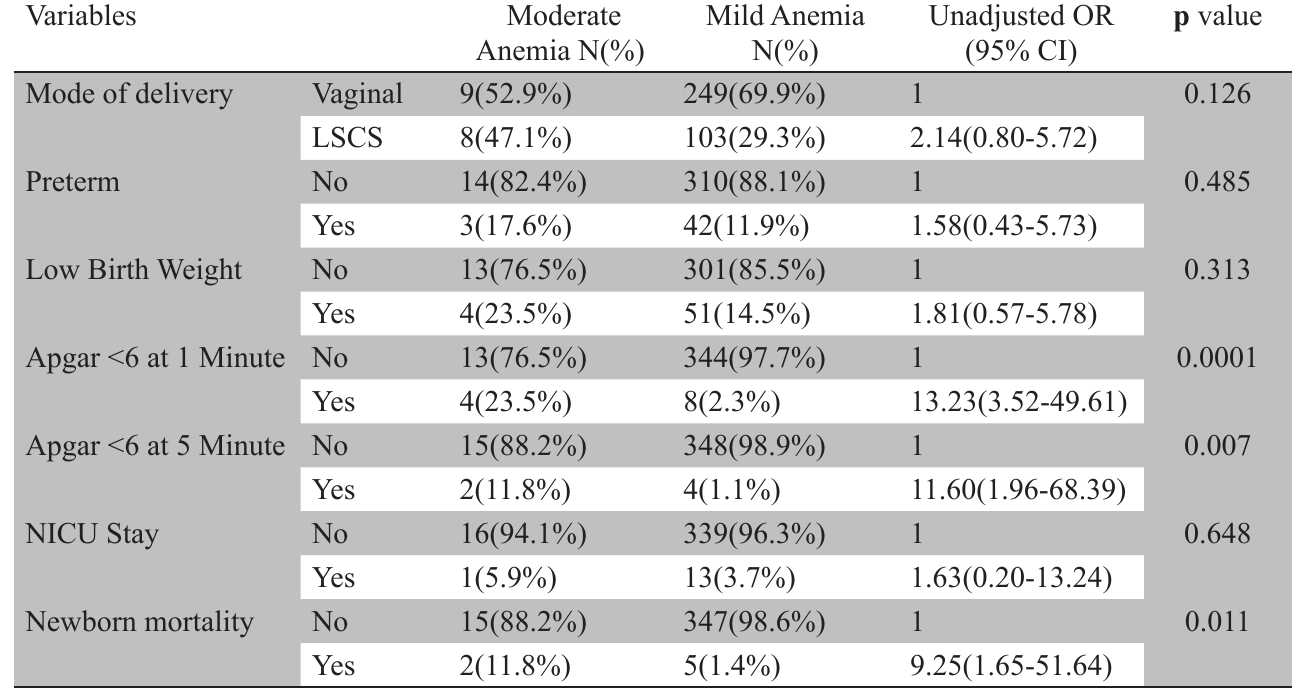
Table 4. Birth outcomes associated with anemia during pregnancy (n=369)